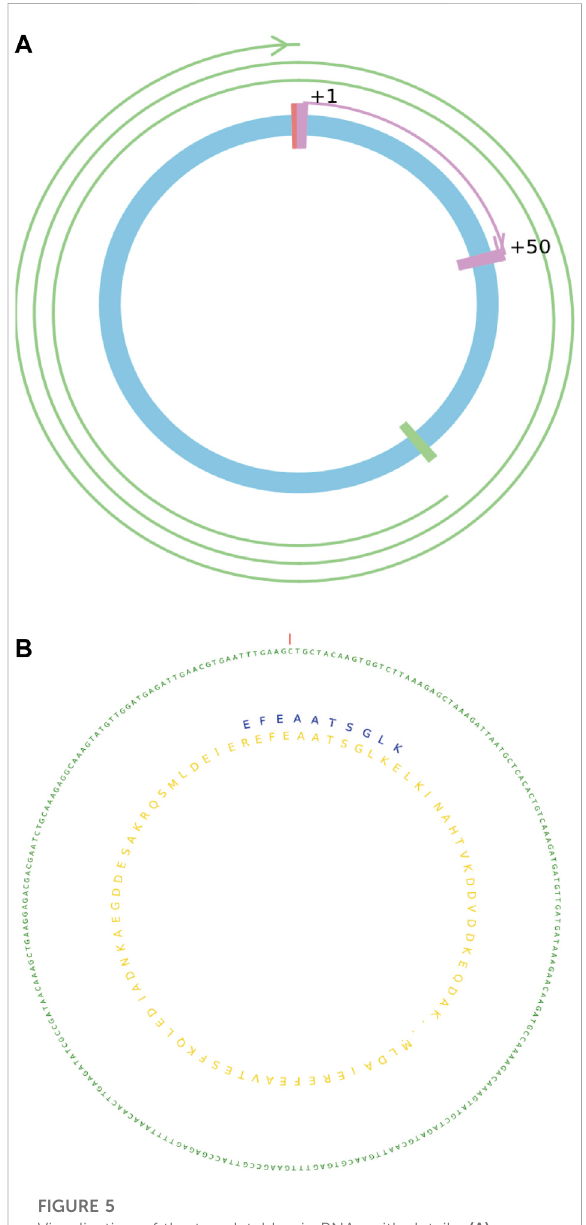
Visualization of the translatable circRNAs with details. (A) cORF information on the translatable circRNA. (B) Sequence information on the translatable circRNA with the translated peptide or